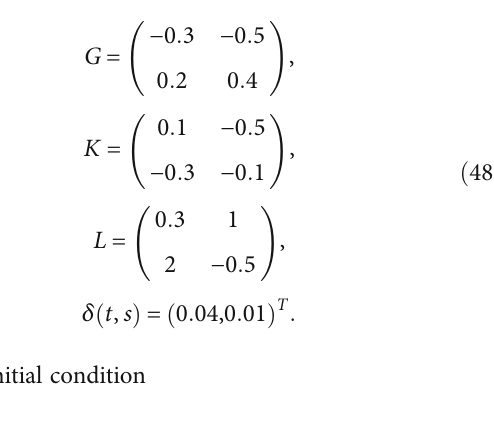
Figure 4: The solution ϑ = ð ϑ The norm k ϑ k = 3 : 7642